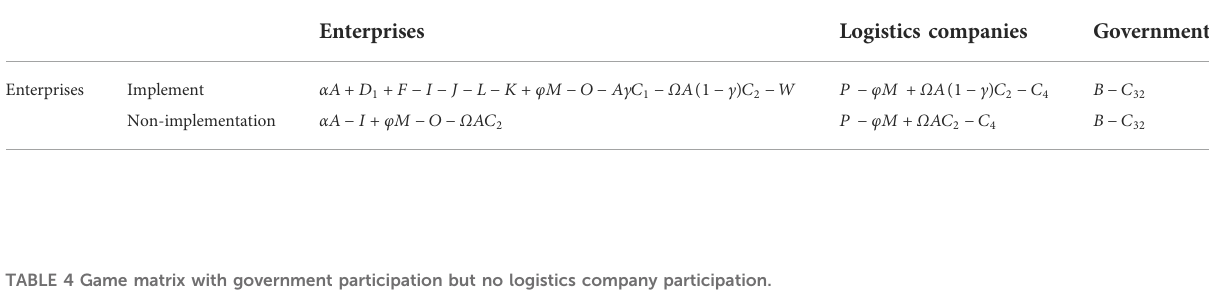
TABLE 3 Game matrix with no government participation but logistics company participation.